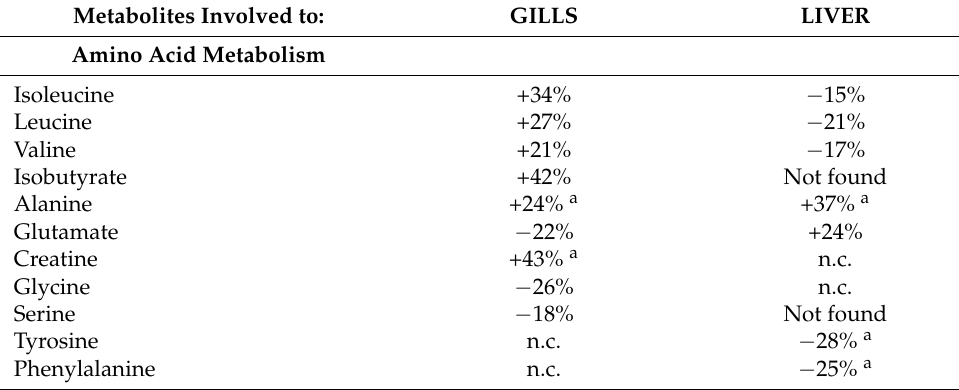
Table 3. The relative changes in metabolite concentrations between LAR and SJ golden grey mullets ( p < 0.05 a ; Student’s t test) in both the gills and liver (+ and − indicate metabolite increase and decrease, respectively, in the organs of fish from LAR with respect to those from SJ; “n.c.” indicates no changes that were induced by Hg